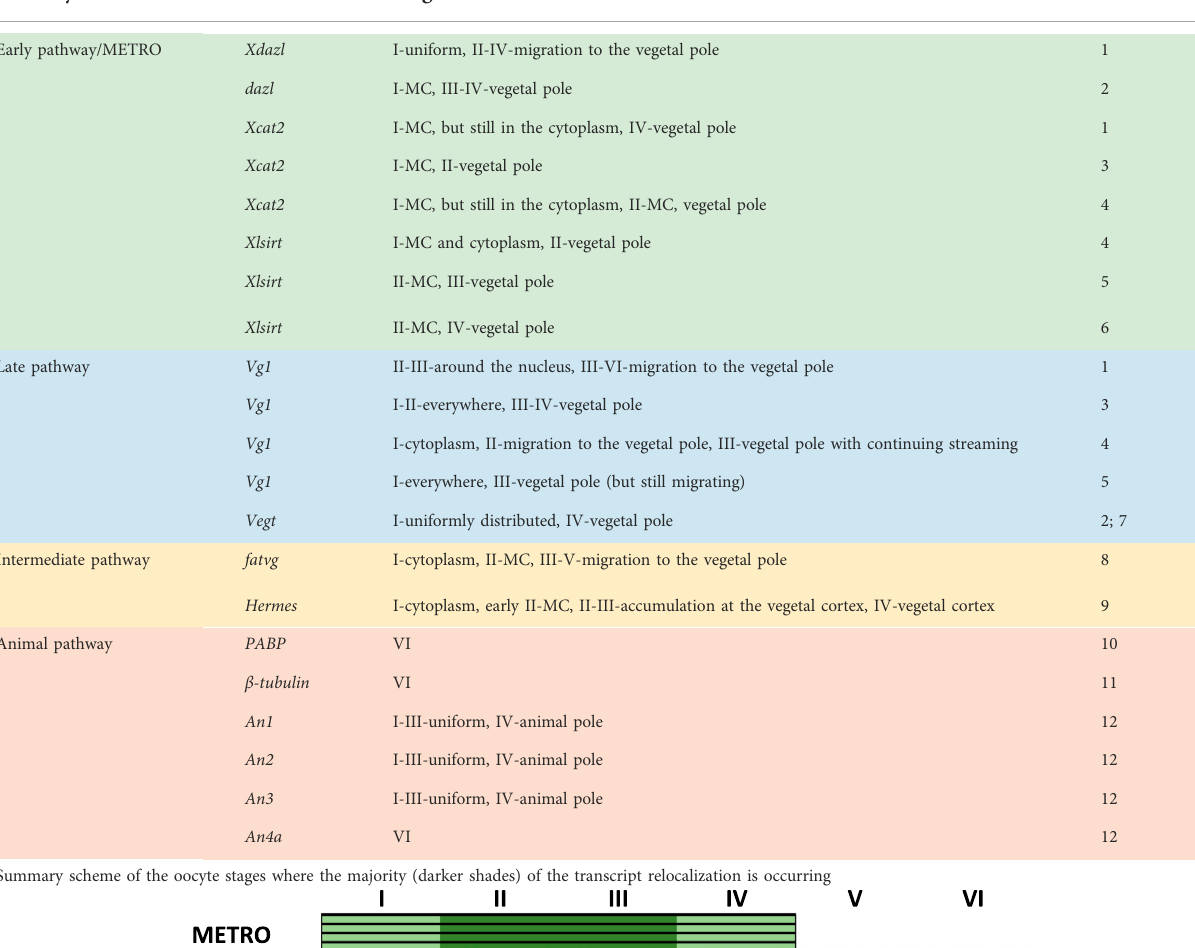
TABLE 1 Localization of maternal transcripts in the oocytes of the Xenopus laevis . Pathway RNAs Stages and